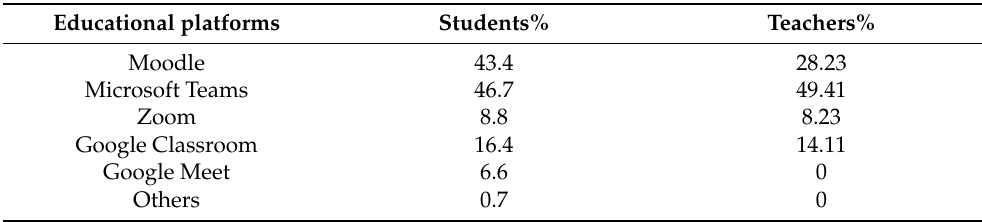
Table 7. The most used educational platforms in online